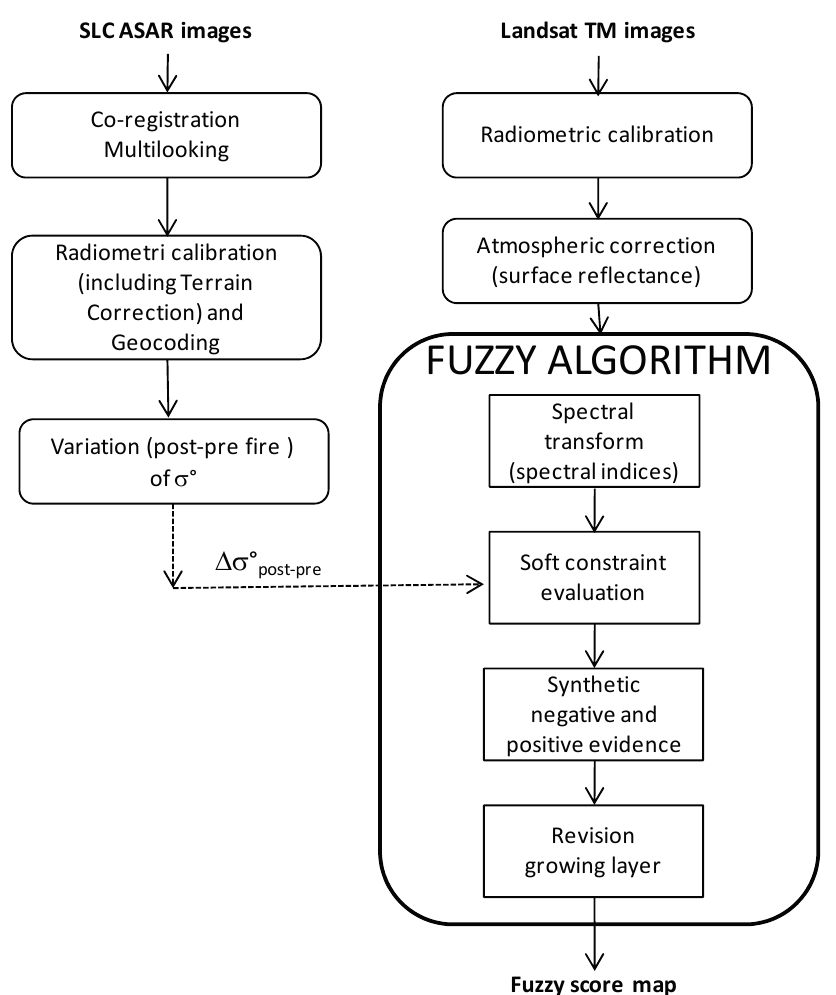
Figure 3. Flowchart of the pre-processing and classification steps implemented for the integration of SAR and optical data in the fuzzy burned area-mapping